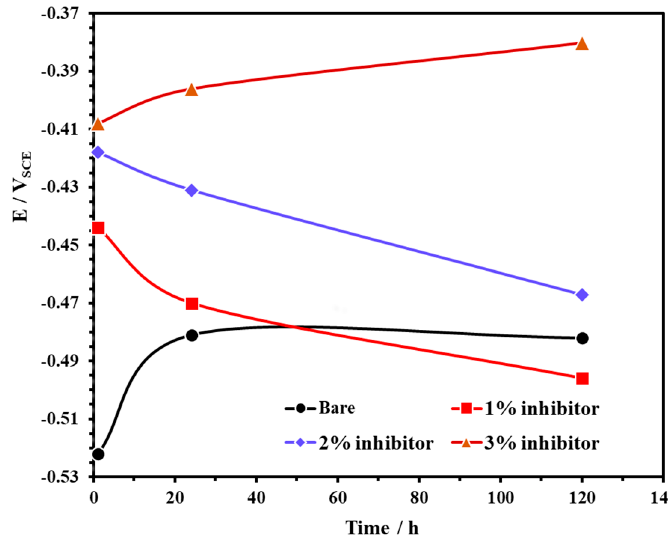
Figure 3. The open circuit potential (OCP) plots of steel rebar exposed to SCP + 3.5 wt% NaCl solution with and without inhibitor.